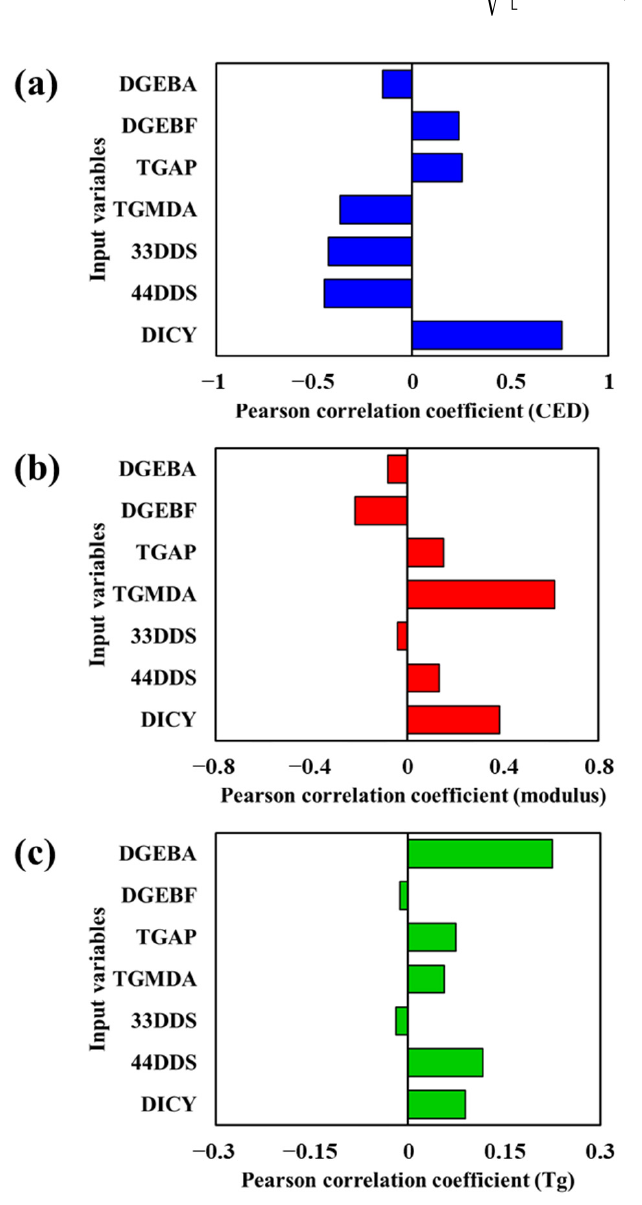
Figure 3. Pearson correlation coefficients for relationships ( a ) between input variables and cohesive energy density, ( b ) between input variables and modulus, and ( c ) between input variables and glass transition temperature.